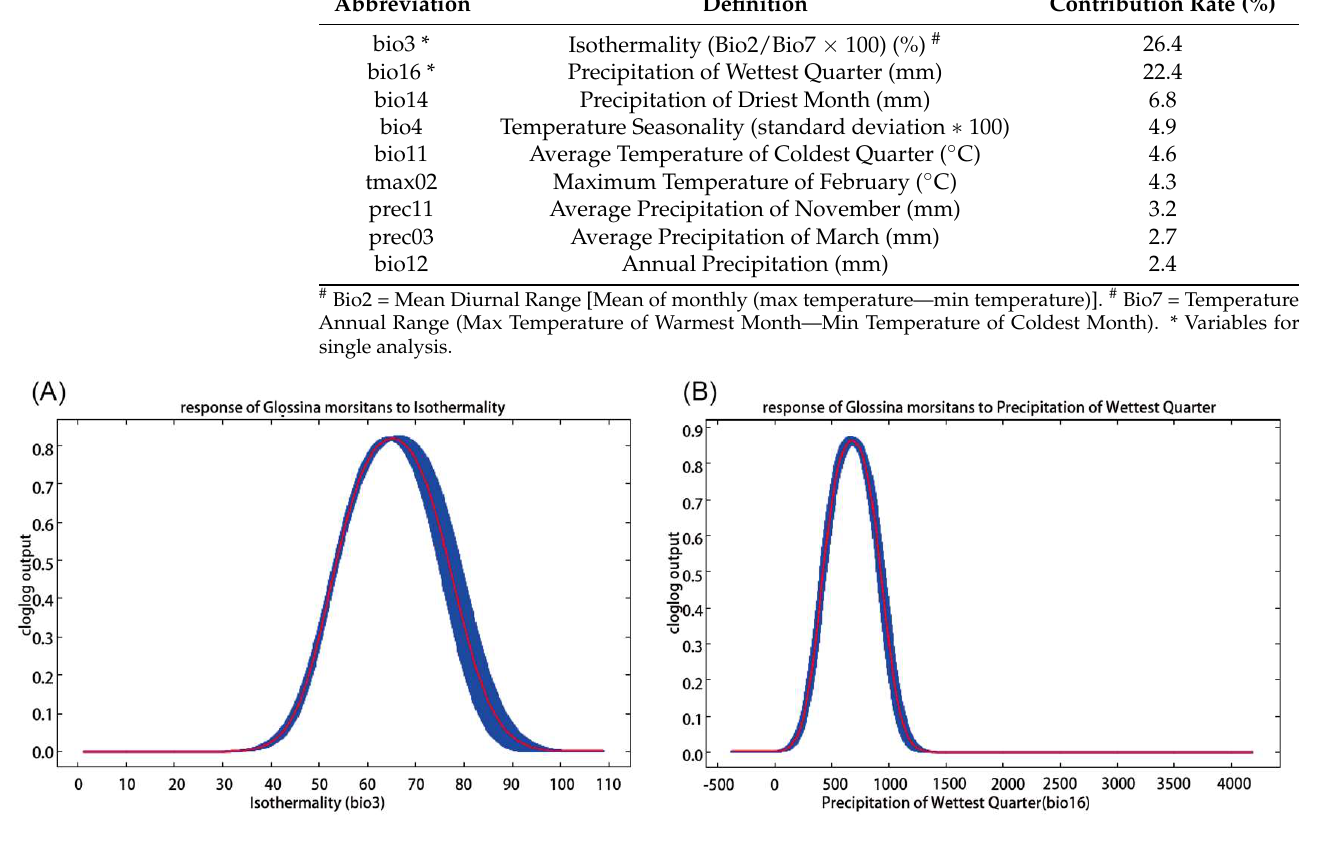
Figure 3. Response curves for dominant climatic factors.